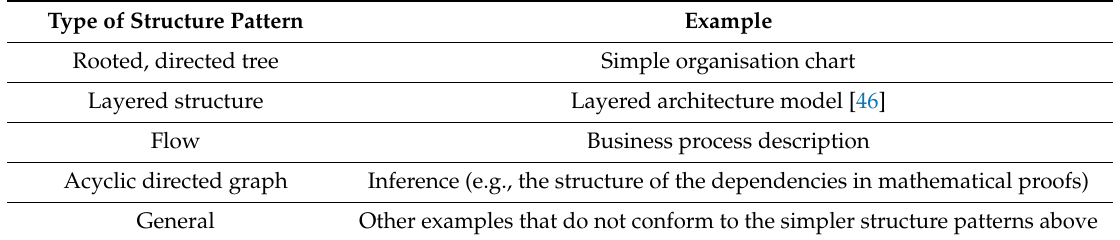
Table 2. Some examples of information structure